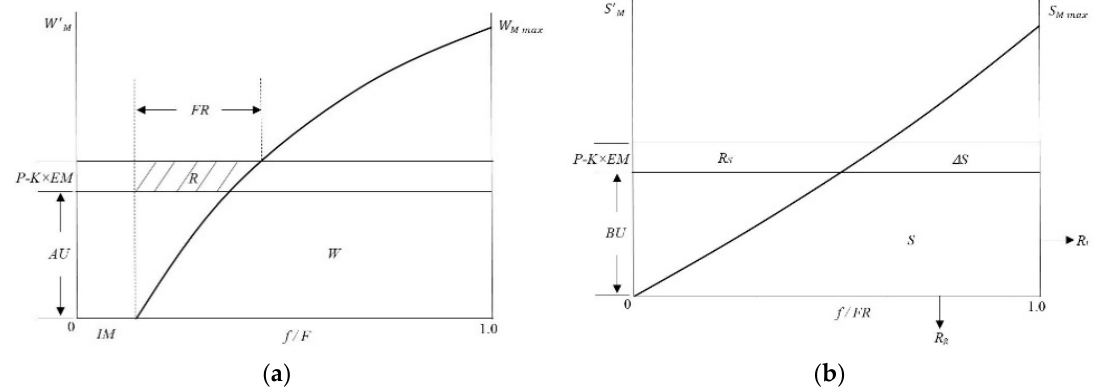
Figure 1. The distribution of tension water capacity and free water capacity in watershed: ( a ) tension water capacity ( b ) free water capacity.